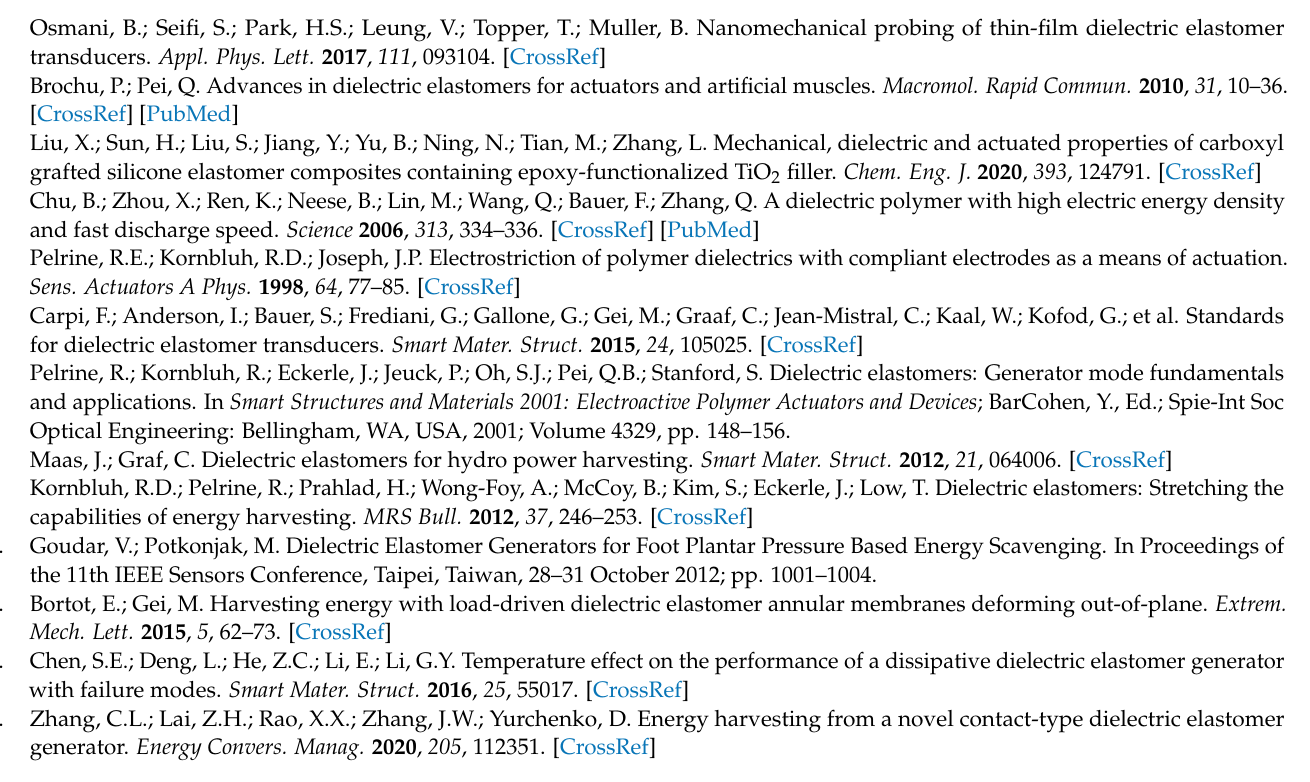
Figure S5: Calculated charge leakage ratio δ under different V 1 . Average value of δ is adopted in simulation of the energy harvesting performances of VHB4905, Table S1: Summary of value of DE film shape and variables in simulation of the energy harvesting performances of